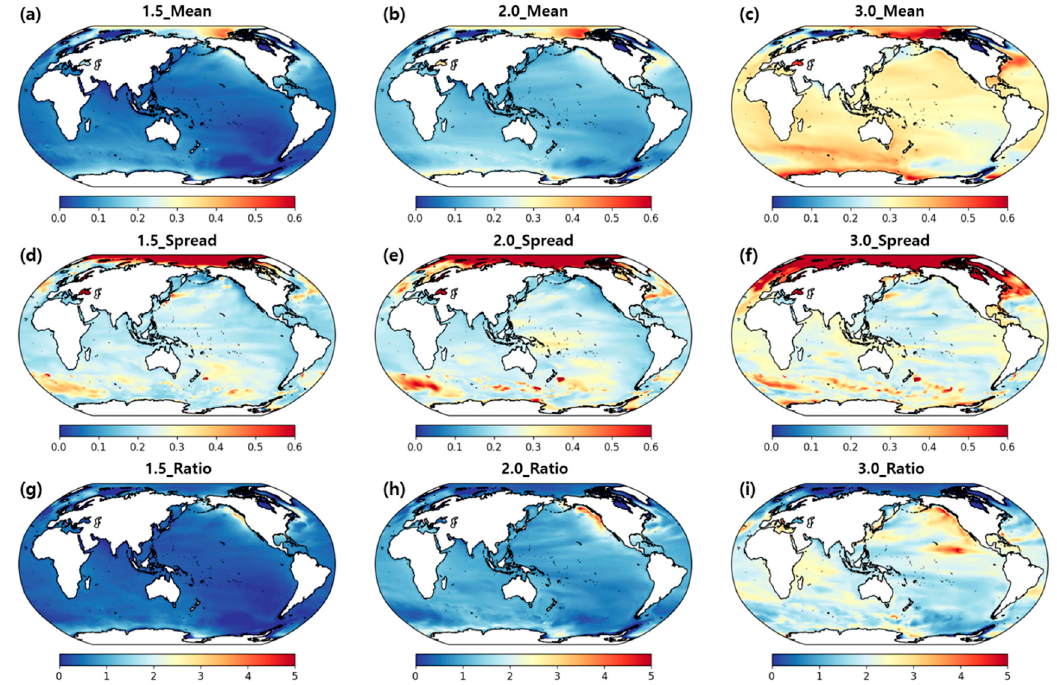
Figure 2. Projection of total SLR from CMIP6 models ( a – c ) and their spread ( d – f ) for three Paris Climate targets (T15 ( left column ), T20 ( mid column ), and T30 ( right column )). The ratio of mean and spread ( g – i ) of CMIP6 models is shown in the bottom row. The unit of SLR is